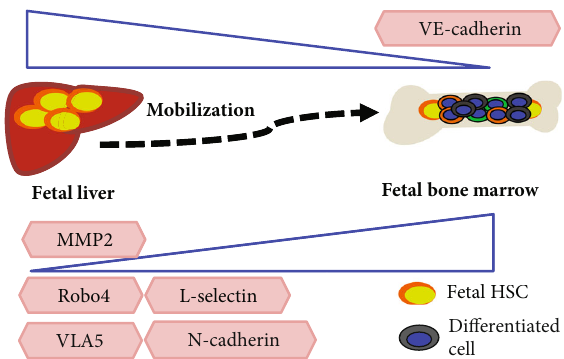
Figure 4: Adhesion molecules regulate fetal liver HSC mobilization into the fetal bone marrow. Increasing levels of MMP2, Robo4, L- selectin, VLA5, and N-cadherin in fetal bone marrow HSCs are involved in HSC mobilization from the fetal liver. Decreasing VE- cadherin expression in fetal HSCs favors HSC mobilization from the fetal